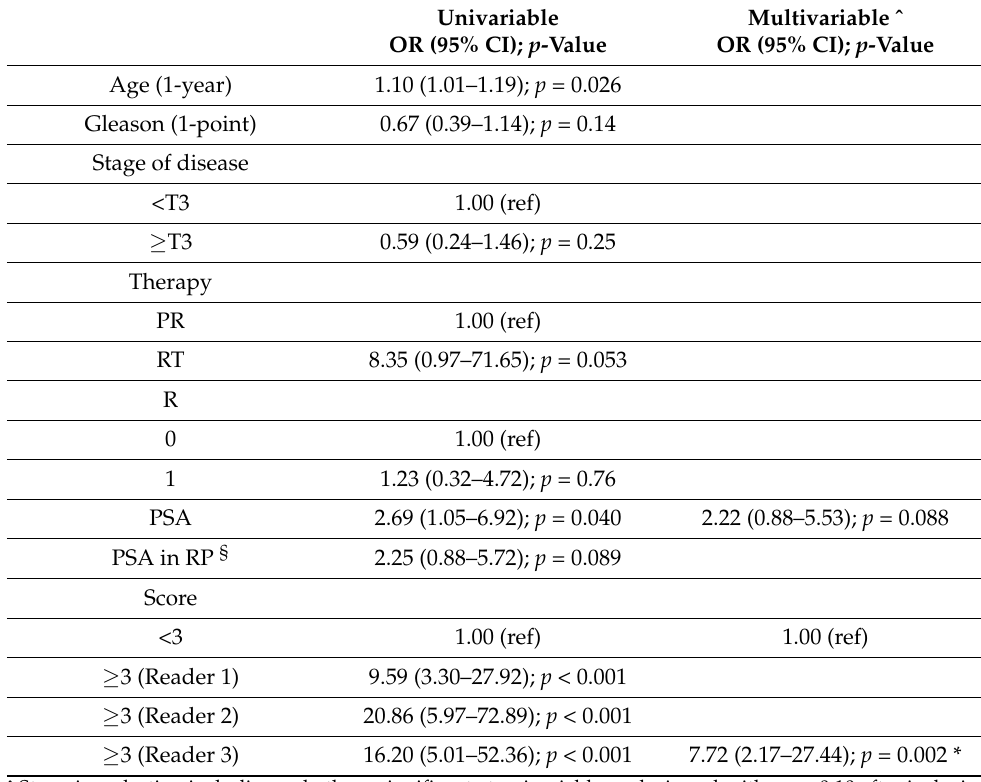
Table 2. Univariate and multivariate correlation